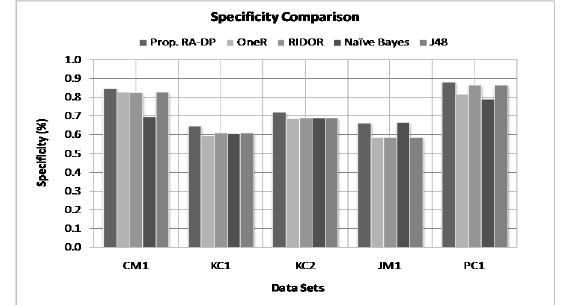
Fig. 6: Specificity Comparison